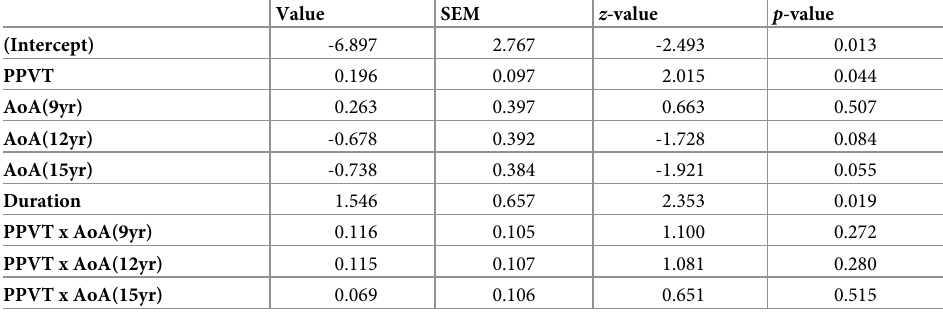
Table 3. Linear mixed model for combined data from Experiment 1 and 2, collected using -7 dB SNR level and mixed